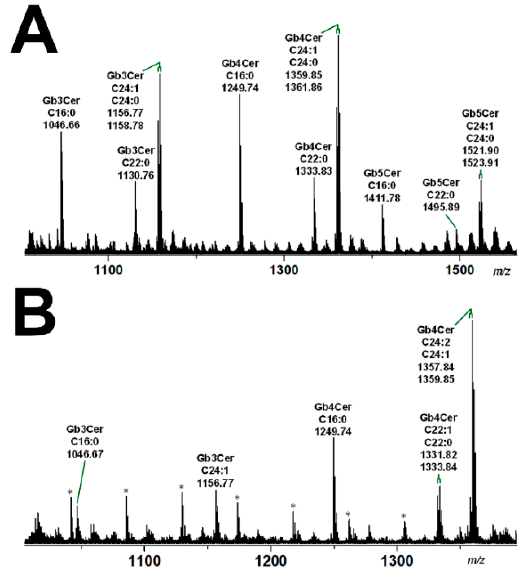
Figure 4. Overview MS 1 spectra of the globo-series GSLs detected in the GSL preparations of pHRPTEpiCs ( A ) and pHCoEpiCs ( B ). The spectra show the various lipoforms of Gb3Cer, Gb4Cer, and Gb5Cer carrying sphingosine (d18:1) as the sole sphingoid base and variable fatty acyl chains as indicated. GSLs were detected as monosodiated species using the positive ion mode. The asterisks mark polyethylenglycols, which appear as serial contaminations in the GSL preparation of pHCoEpiCs. For further details refer to Detzner and collaborators [193,194], where the data were taken from.